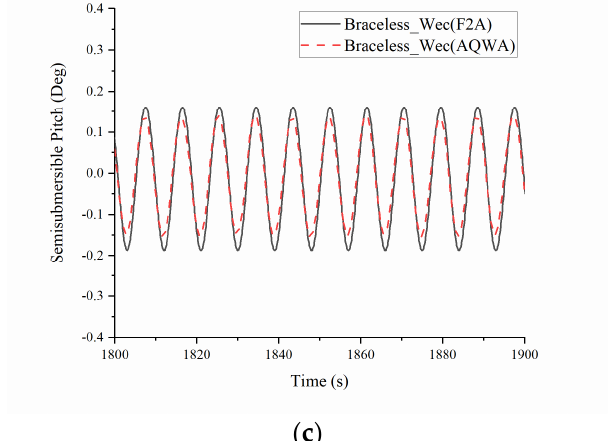
Figure 5. Time domain motion response of the semisubmersible platform: ( a ) Surge; ( b ) Relative Heave; ( c ) Pitch.